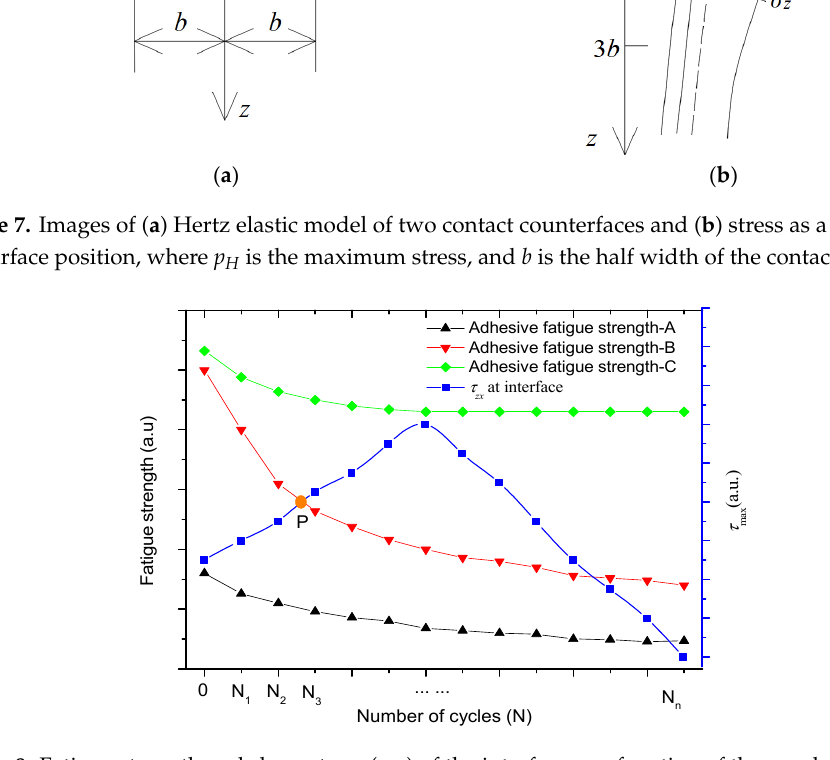
Figure 8. Fatigue strength and shear stress ( τ zx ) of the interface as a function of the number of cycles.